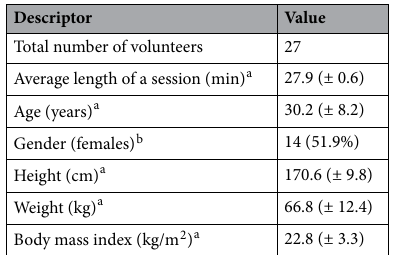
a Mean (± standard deviation).